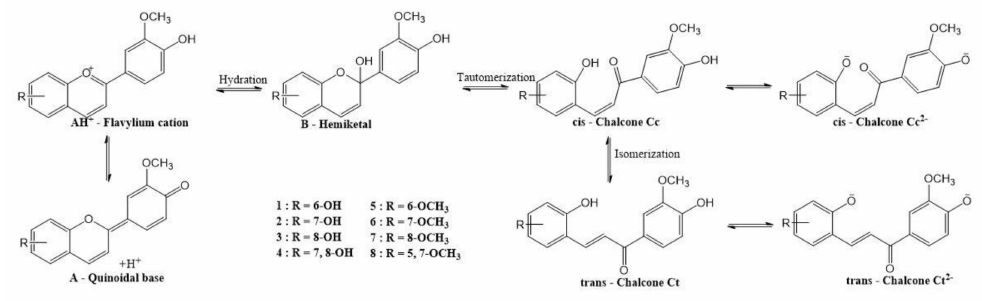
Figure 5. The network of chemical reactions of the synthetic anthocyanidins upon pH